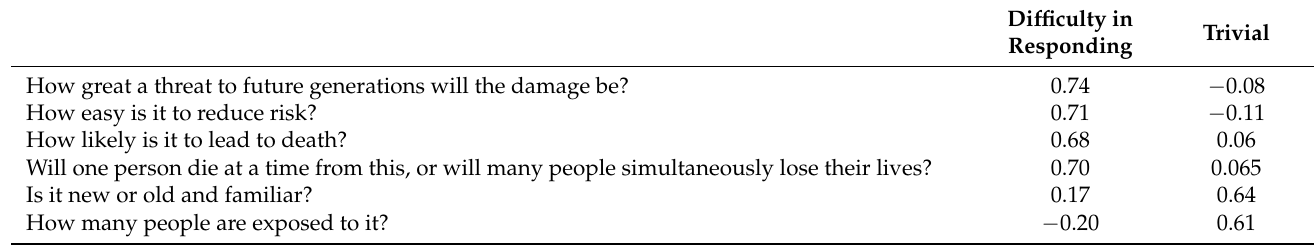
Table 1. Results of the factor analysis of risk characteristics.